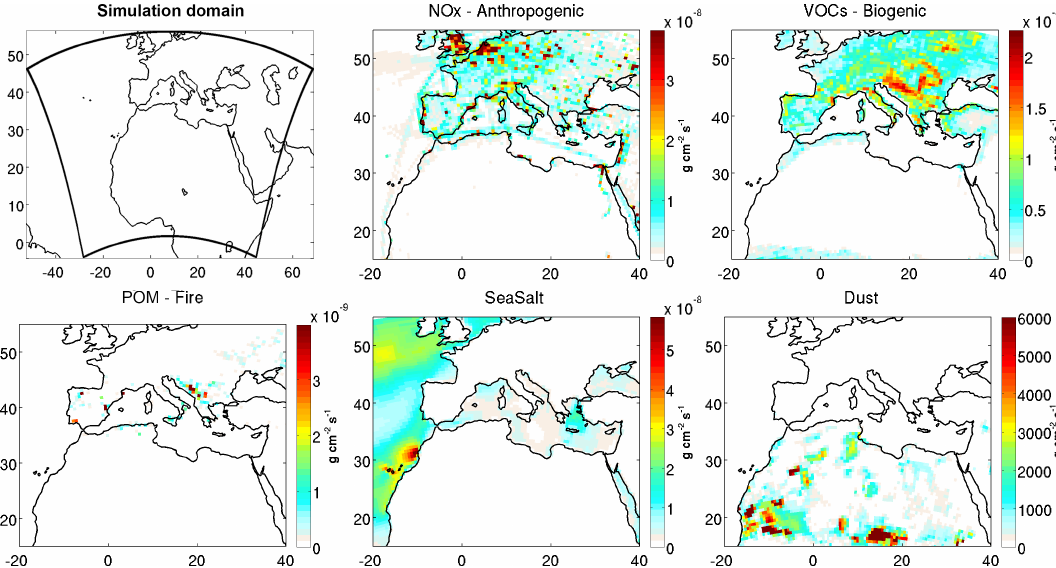
Figure 5. Total fluxes of different aerosol precursors or primary aerosol from each source averaged during the summer of 2012: anthropogenic emissions of nitrogen oxides (NO x ), biogenic emissions of volatile organic compounds (VOCs), fire emissions of primary organic matter (POM), mineral dust and sea salt